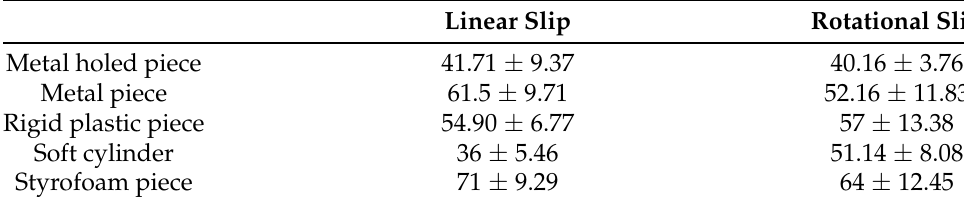
Table 2. Reaction time after slip (all values in